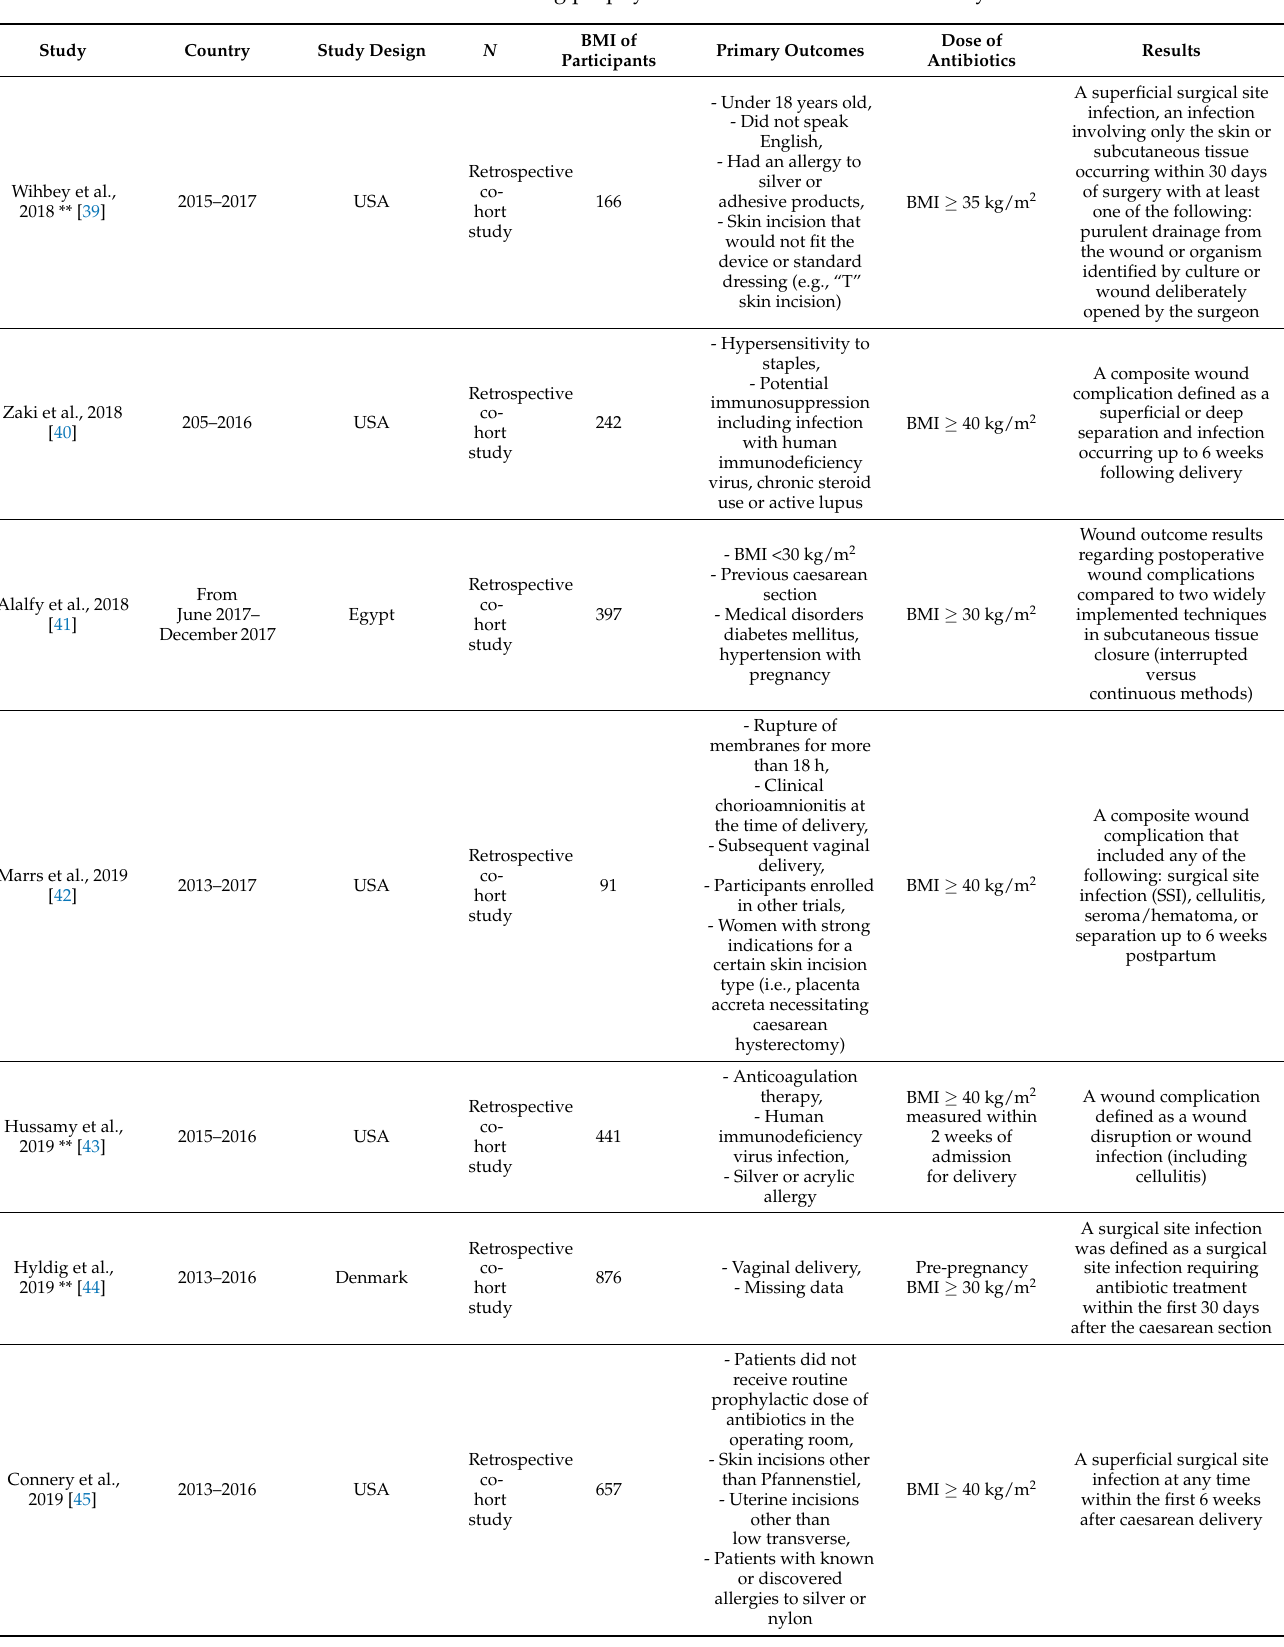
Table 2. Characteristics of studies evaluating prophylactic antibiotics included in the systematic